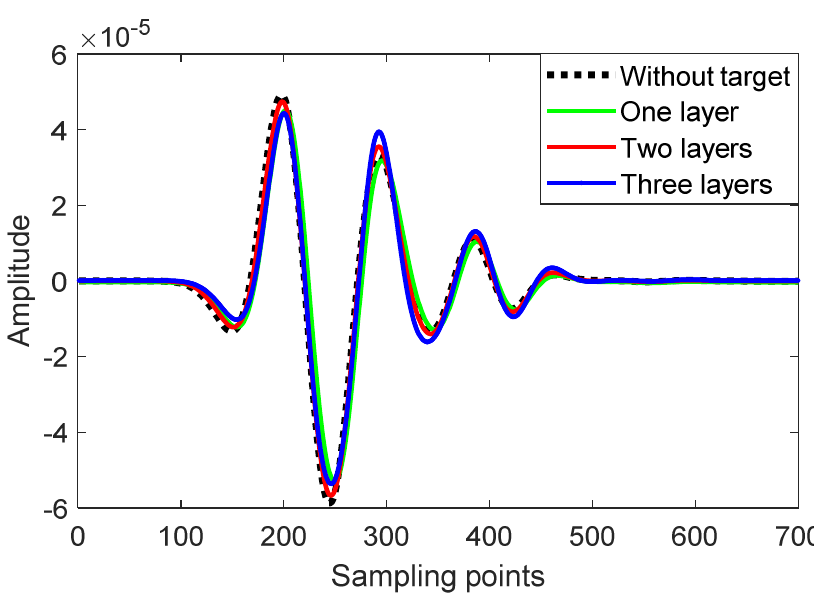
Figure 6. Wavelets predicted by different network layers.